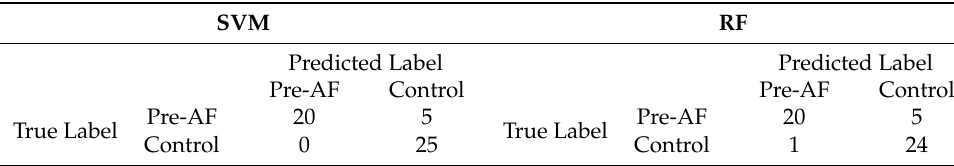
Table 3. Confusion matrix on the test data (immediately before onset).